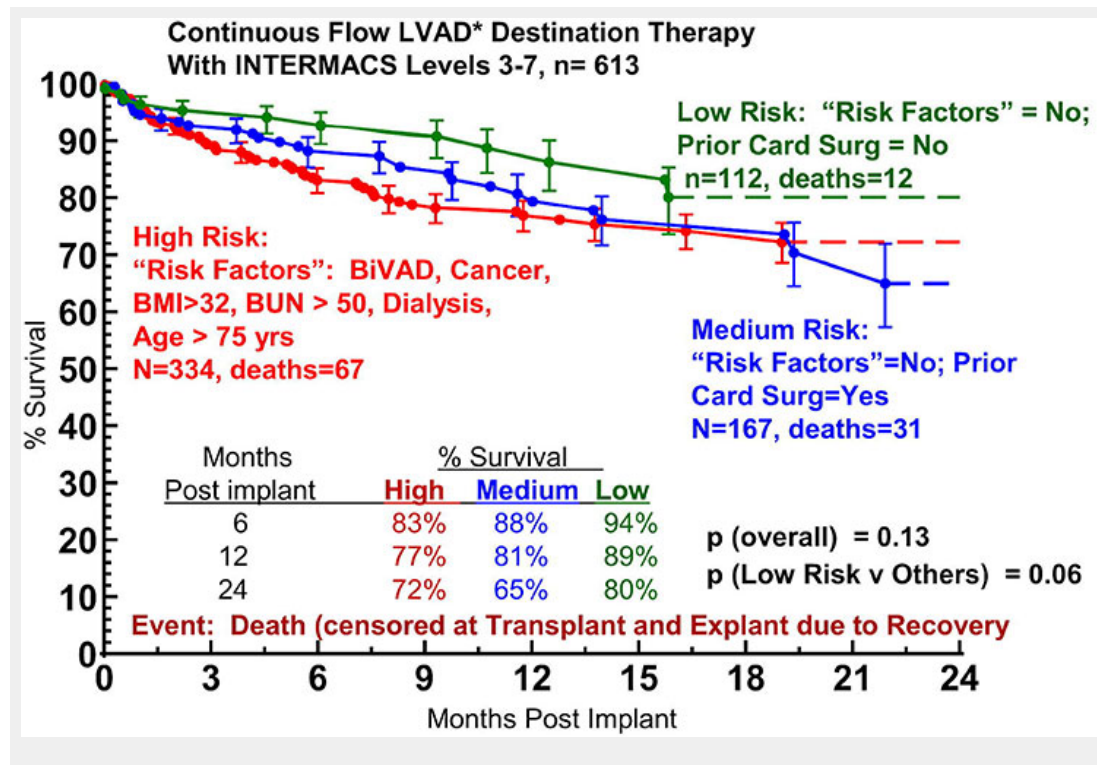
Figure 6 Actuarial survival after continuous-flow device destination therapy of patients with INTERMACS levels 3-7, stratified by high-, medium-, and low- risk patients. INTERMACS, Interagency Registry for Mechanically Assisted Circulatory Support; LVAD, left ventricular assist device. ©